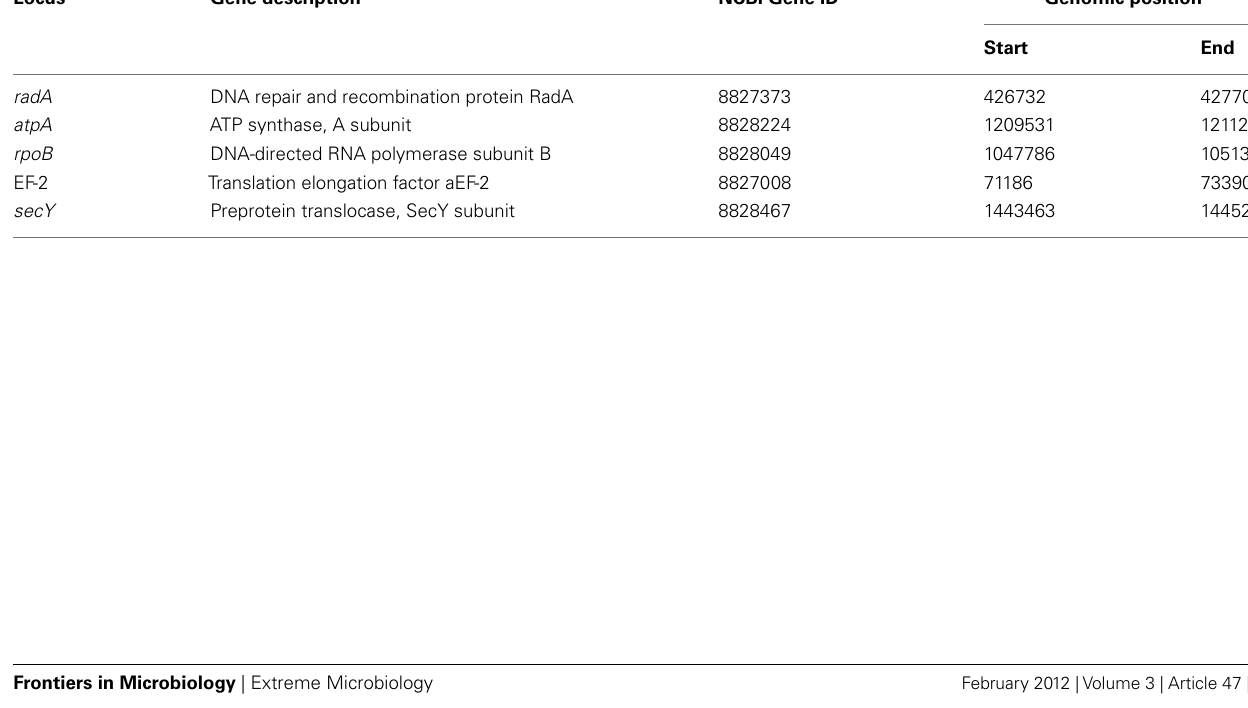
TableA2 | Location of the protein-coding loci in the genome of A. boonei T469 T .